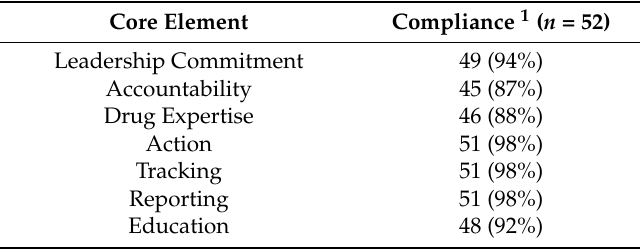
Table 1. Compliance with seven core elements of a hospital antimicrobial stewardship program (ASP).